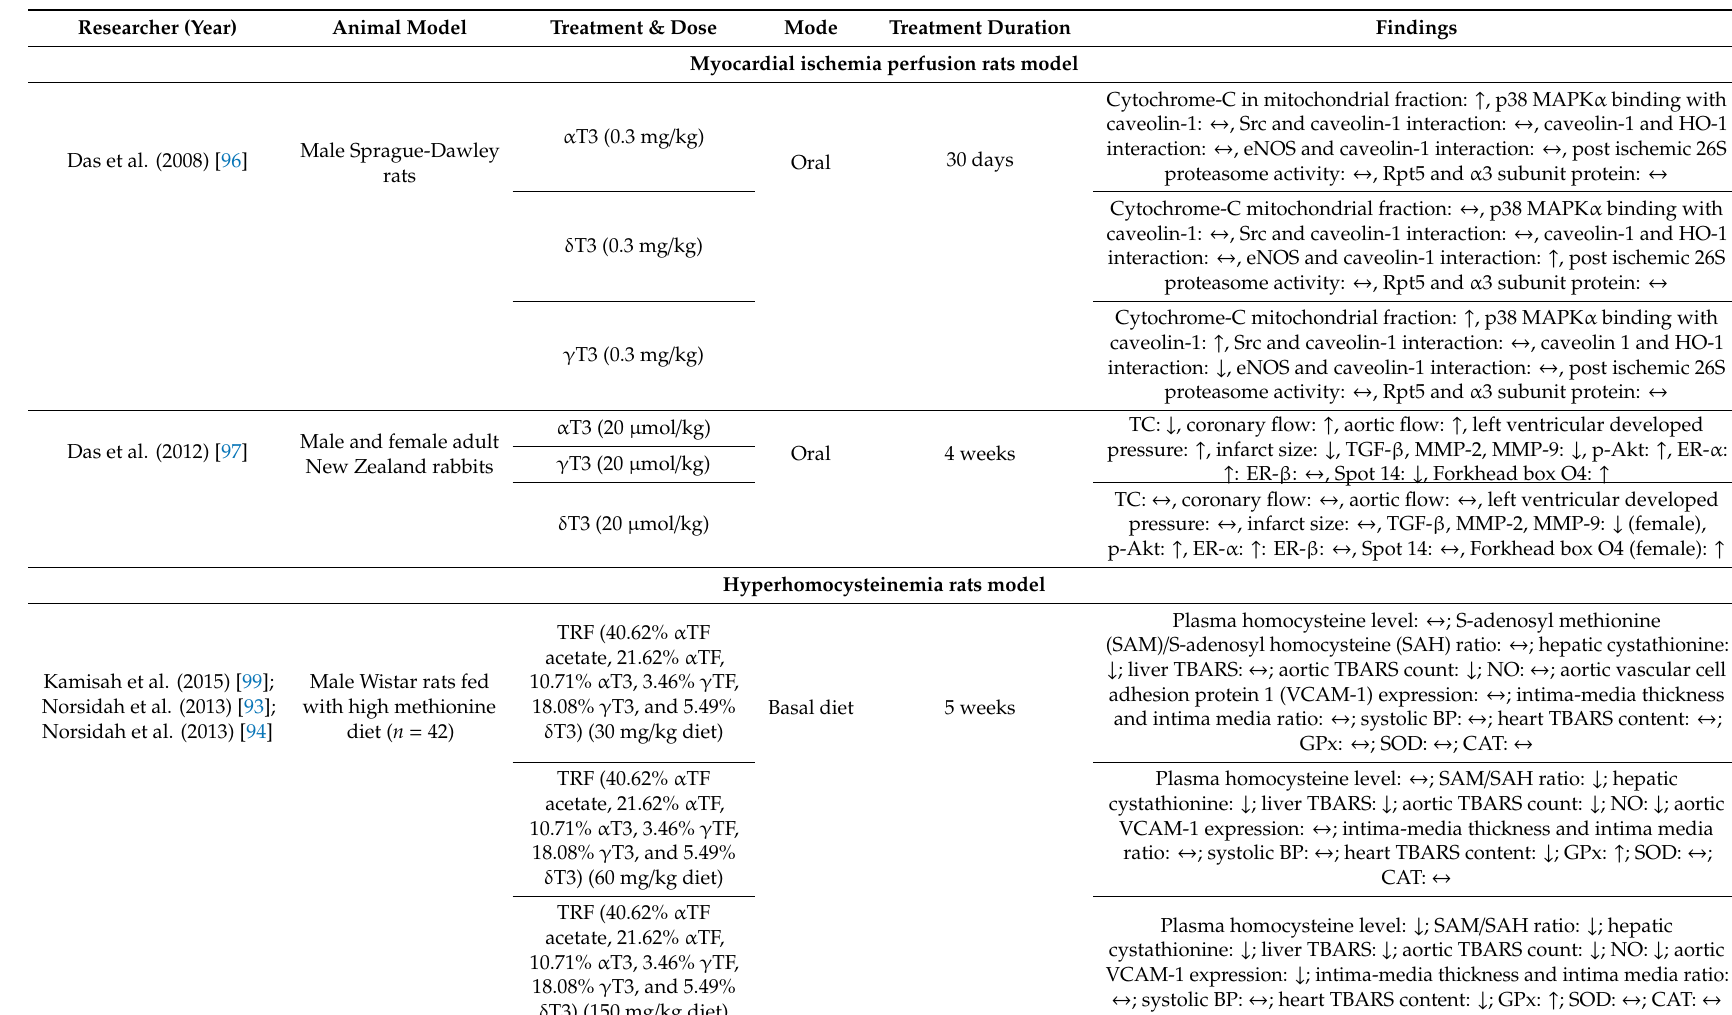
Table 4. E ff ects of T3 on CVD in